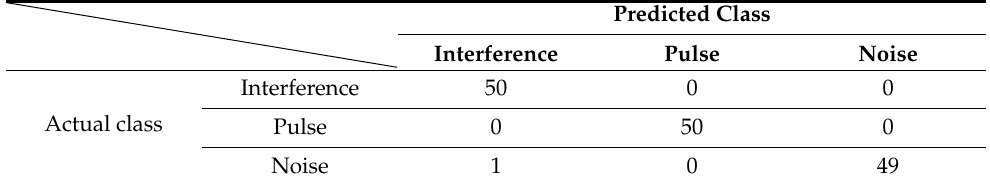
Table 4. Confusion matrix for the test.